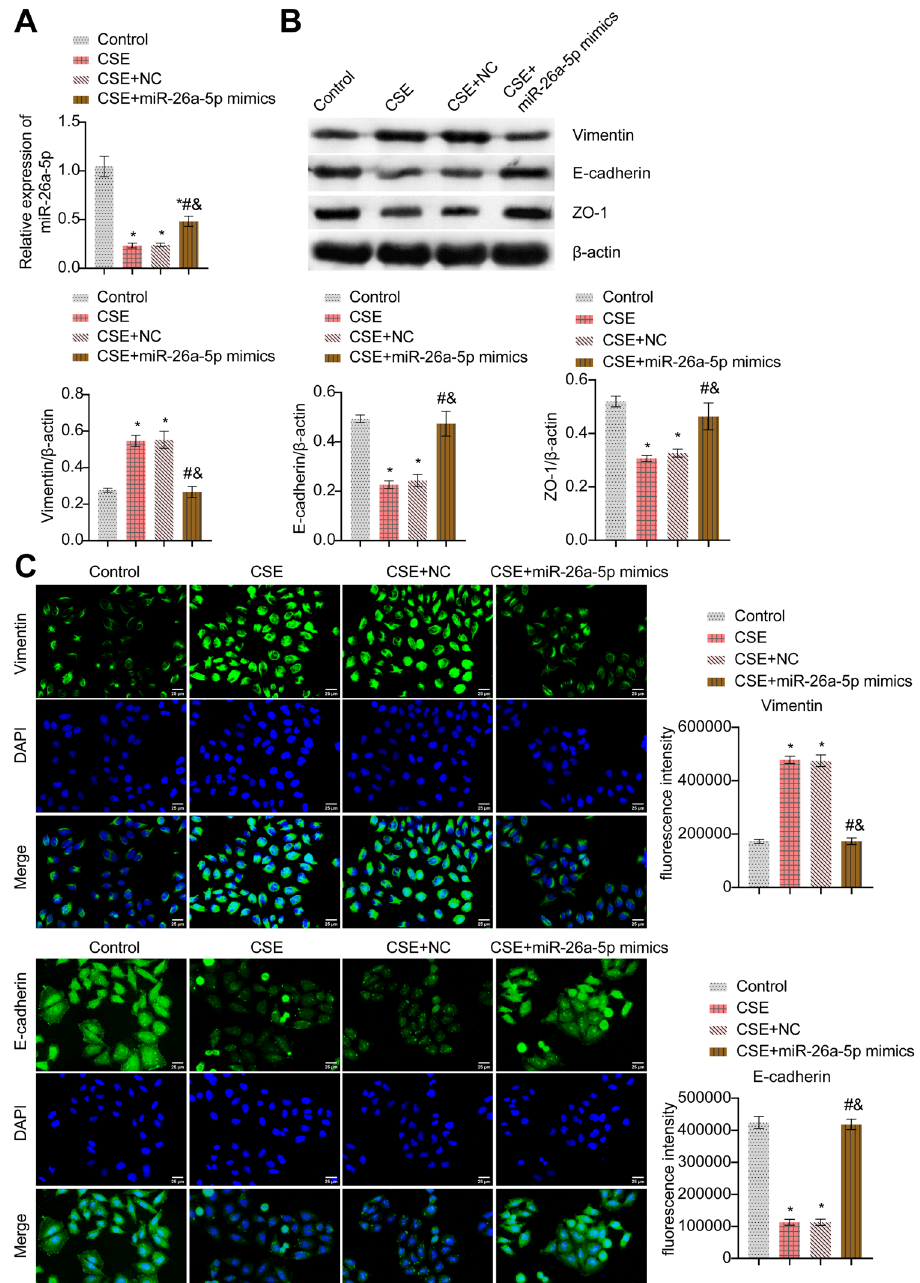
Figure 7. miR-26a-5p affected CSE-induced BECs EMT. ( A ) miR-26a-5p mRNA expression. ( B ) Western blot detection of EMT markers Vimentin, E-cadherin, and ZO-1. ( C ) IF staining of EMT markers Vimentin and E-cadherin. *P < 0.05 vs. Control, #P < 0.05 vs. CSE, &P < 0.05 vs. CSE + NC. The data were presented in the form of mean ± standard deviation. n =